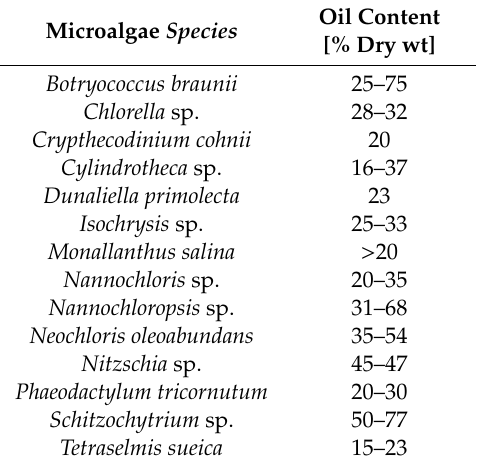
Table 3. Oil content of some microalgae strains (%) [19].